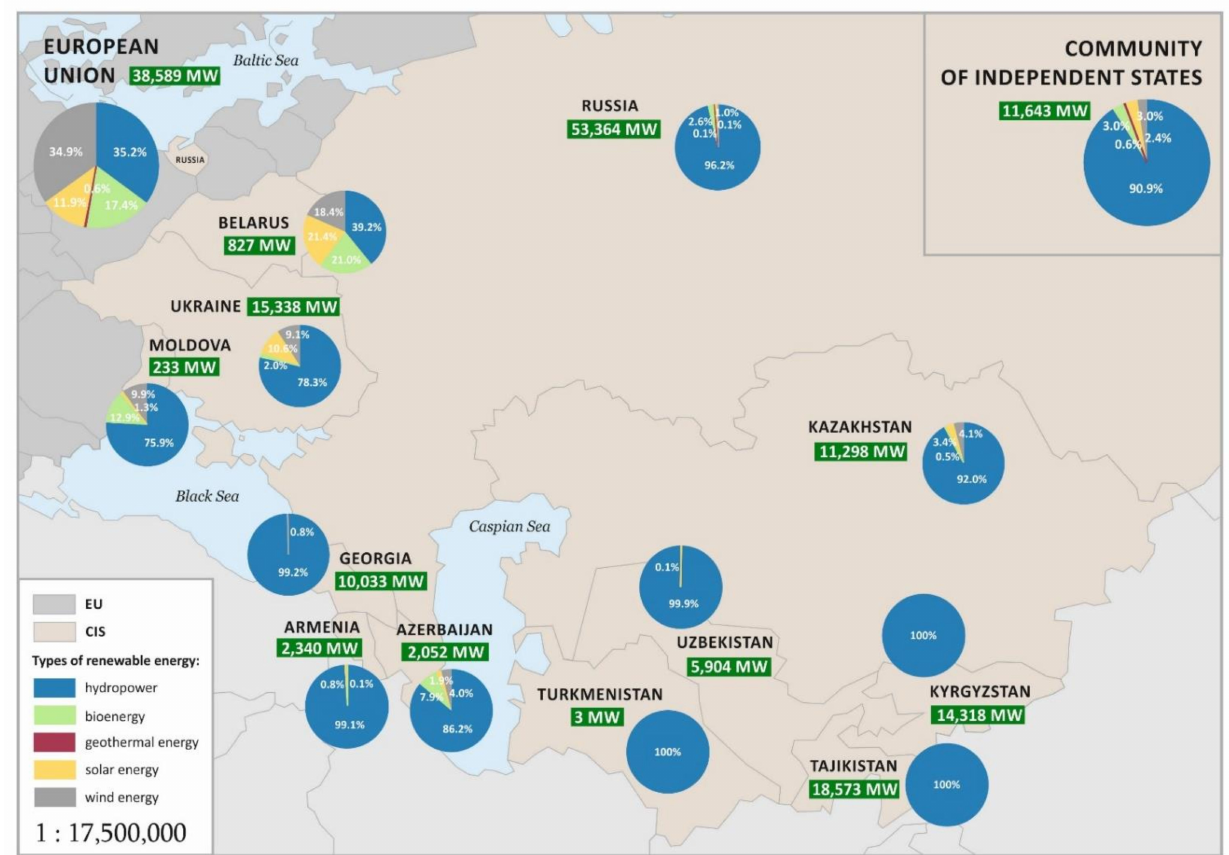
Figure 4. Renewable energy production in the CIS countries in 2018. Source: Own elaboration based on